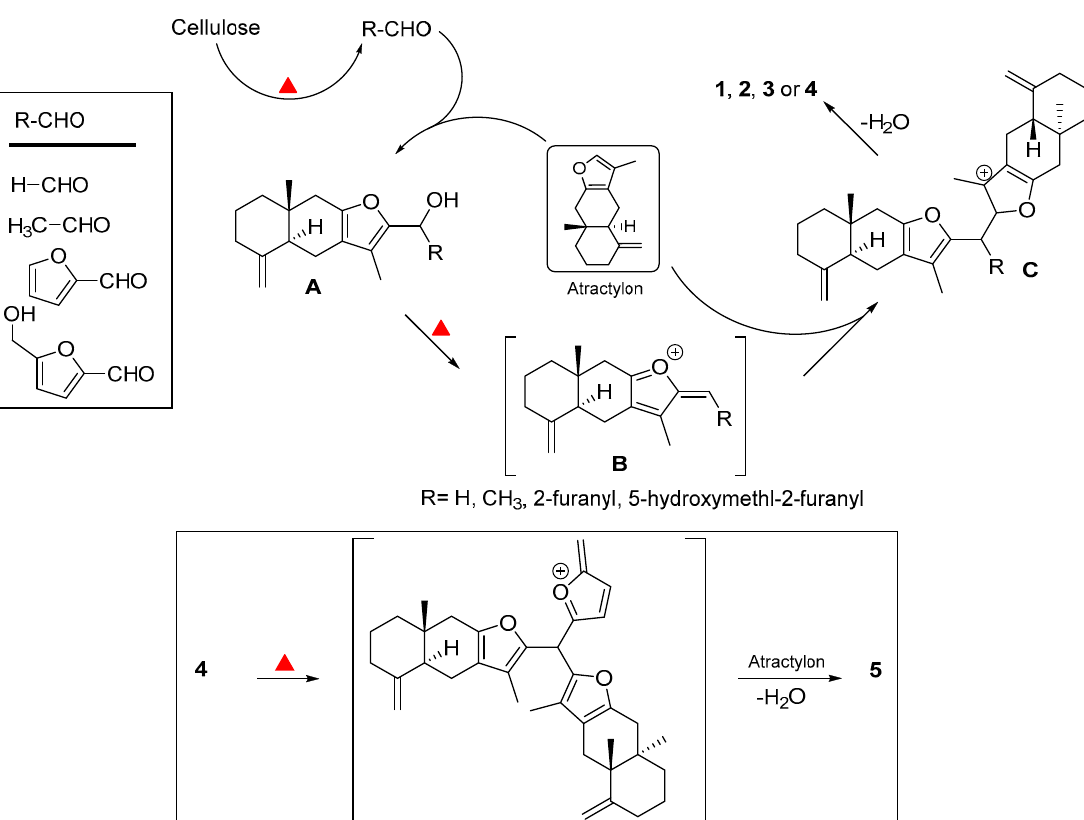
Figure 2. Proposed mechanism for the generation of compounds 1 – 5 .